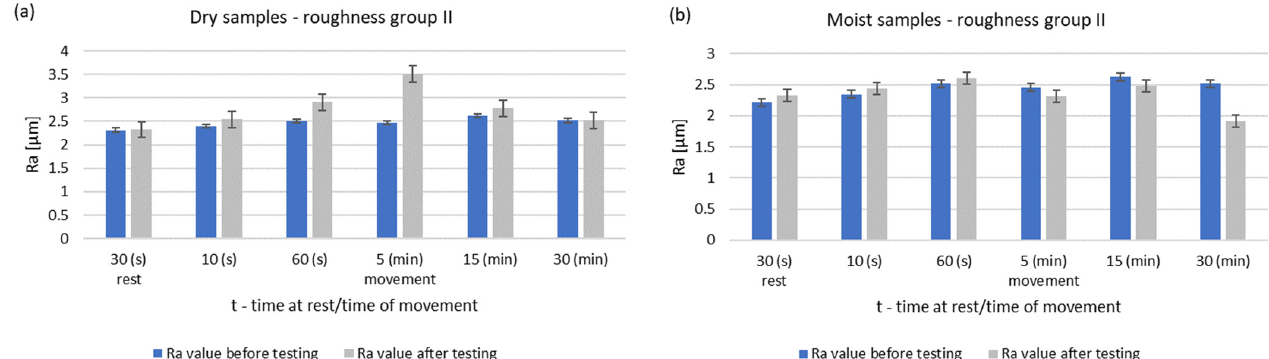
Figure 6. Changes in the value of the parameter Ra of steel pins for roughness group II (Ra = 2.31–2.62 μ m): ( a ) tests performed in dry conditions, ( b ) tests performed with moist graphite rings.